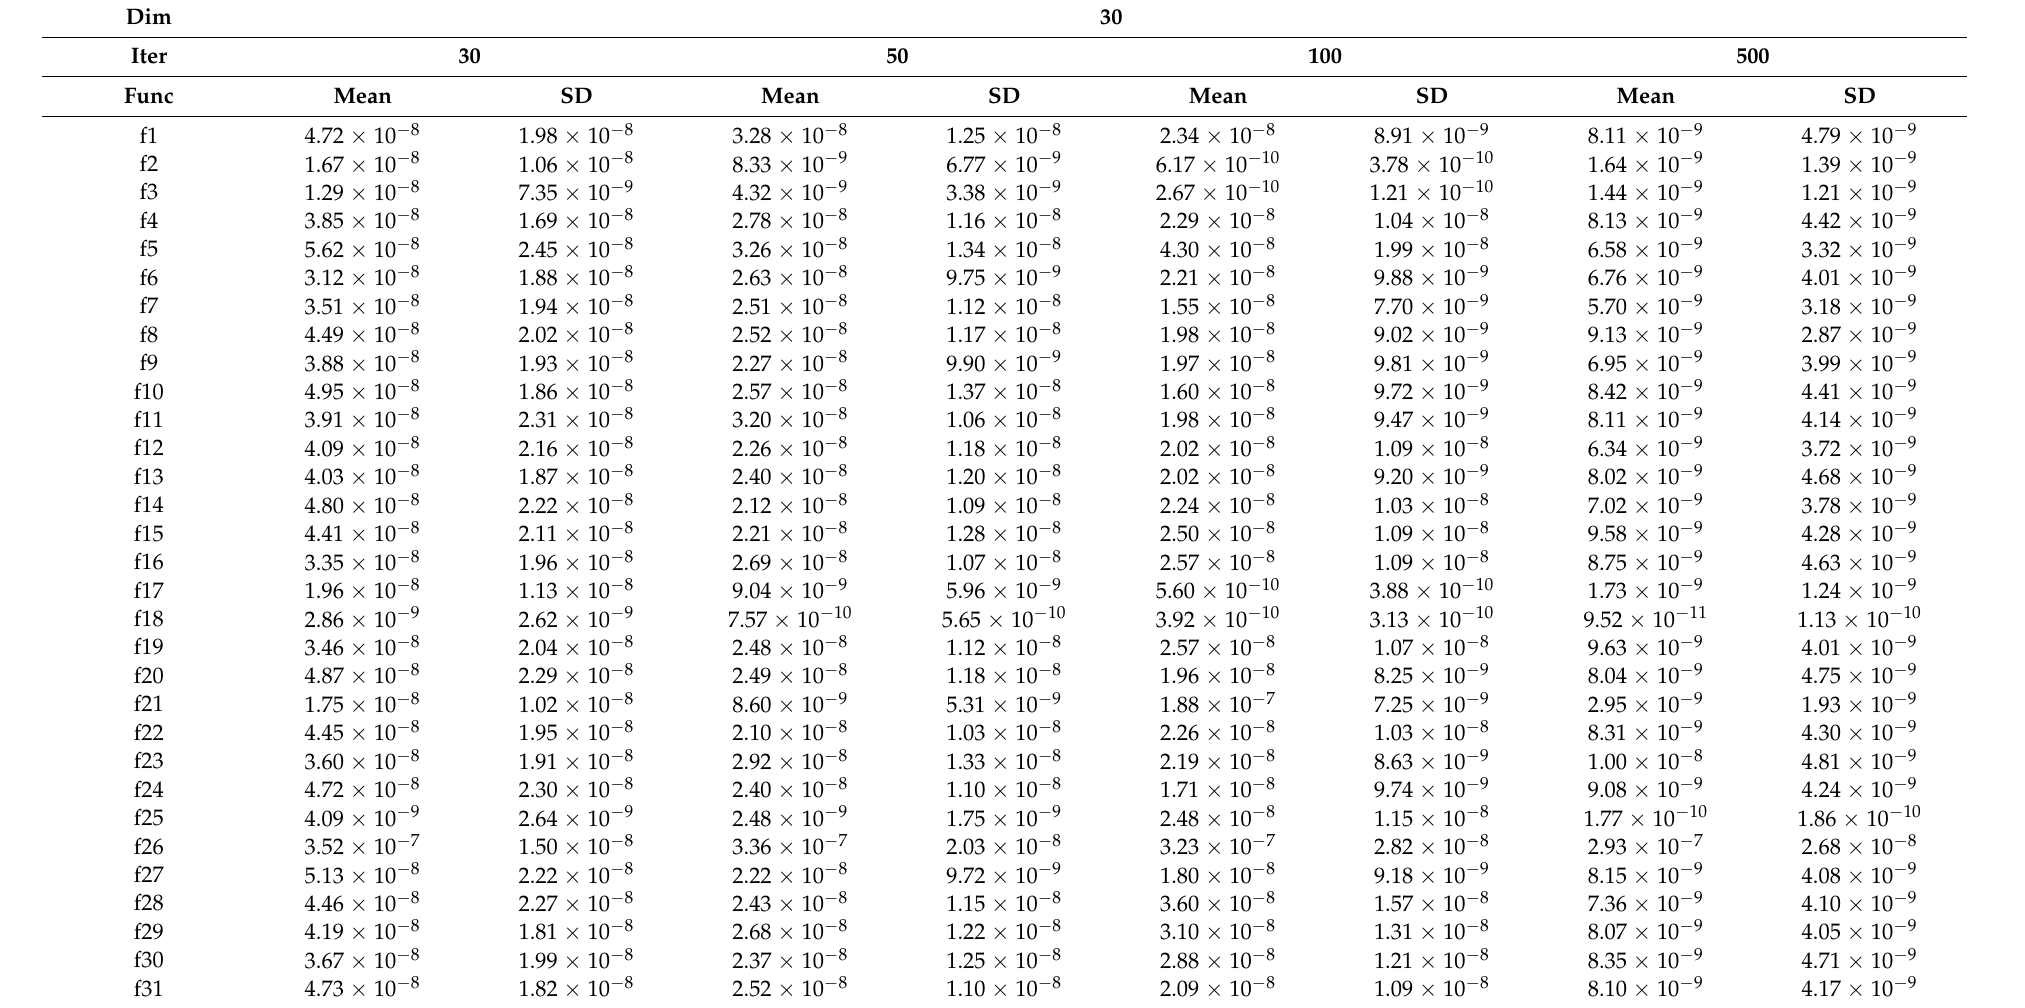
Table 4. MTOA: Results of the experiments for 30